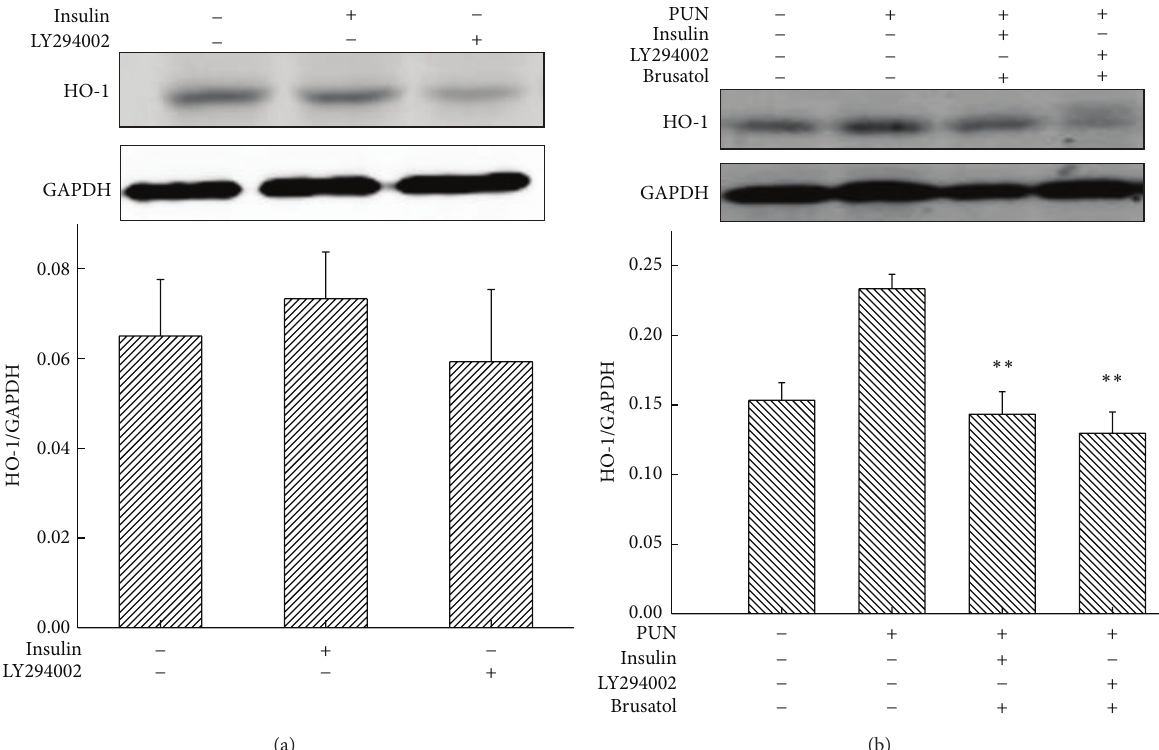
Figure 5: Blocking Nrf2 suppresses modulatory effect of PI3K/Akt pathway on PUN-induced HO-1 protein expression. RAW264.7 cells were treated for 8 h with 100 𝜇 M PUN in the presence or absence of indicated inhibitor (LY294002, 20 𝜇 M; brusatol, 10nM) and inducer (insulin, 10 𝜇 M) at 37 ∘ C in a humidified incubator with 5% CO 2 . The HO-1 protein expression was analyzed by Western blotting. Data represent the mean ± SEM of three independent experiments and differences between mean values were assessed by one-way ANOVA. ∗∗ 𝑃 < 0.01 indicates significant differences compared with the PUN-treated